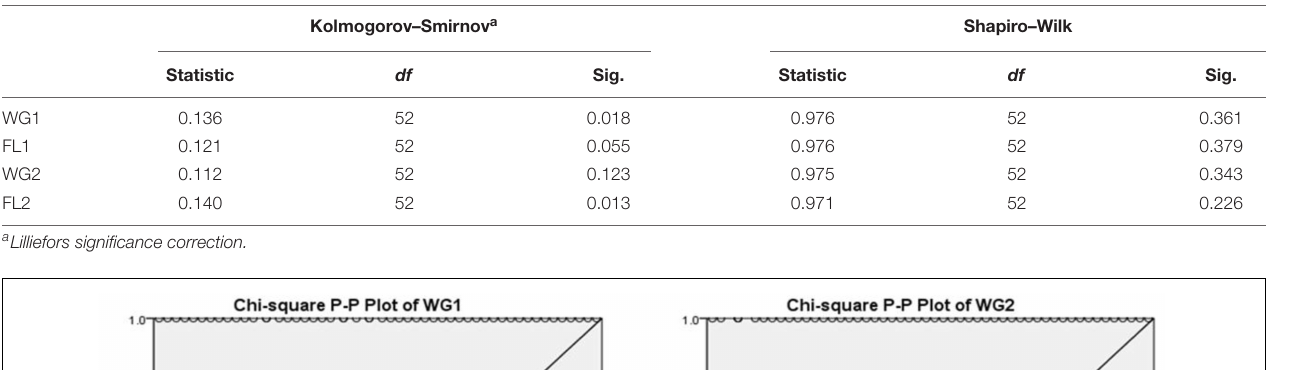
TABLE 4 | Tests of normality.